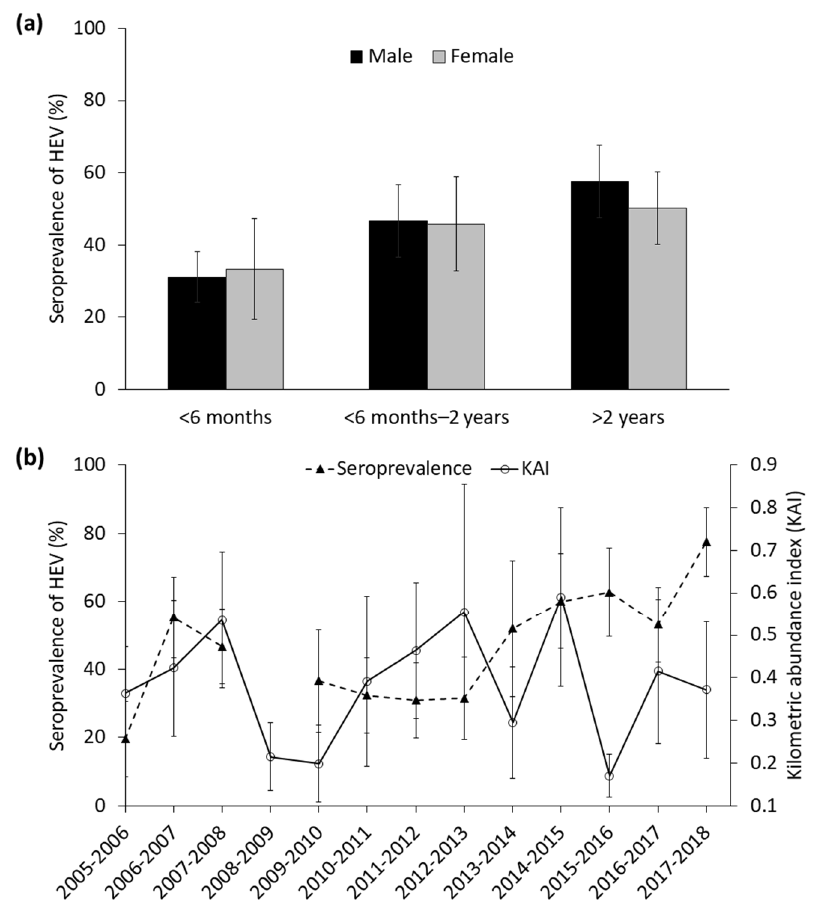
Figure 2. ( a ) Seroprevalence (% ± standard error (S.E.) 95%) of HEV depending on age class and sex. ( b ) Temporal trend of the seroprevalence of HEV ( ± S.E. 95%) and the average ( ± S.E.) relative abundance of wild boar (KAI).